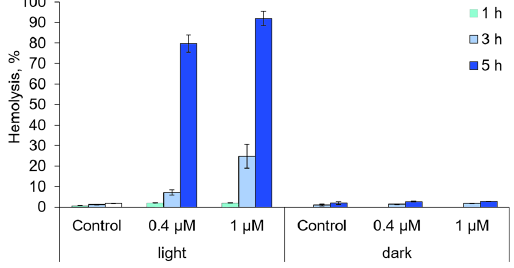
Figure 8. The degree of erythrocytes’ hemolysis during incubation with the tested Compound 21 (0.4 and 1 μ M) for 1, 3, and 5 h.